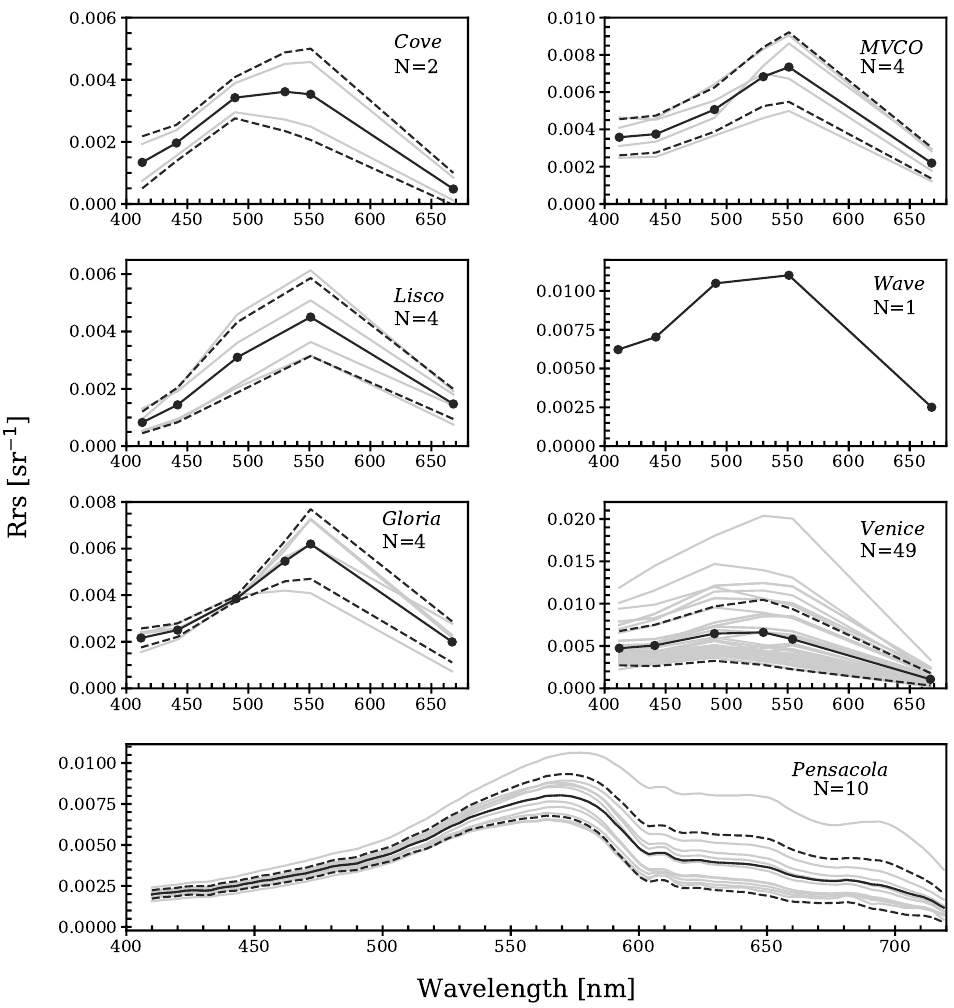
Figure 2. In situ Rrs spectra from AERONET-OC sites and Pensacola Bay (match-ups). The continu- ous black lines indicate mean values, the dashed lines indicate ± 1 standard deviation and the grey lines are all matched data with Polymer and L2gen. N represents the number of match-up spectra at each